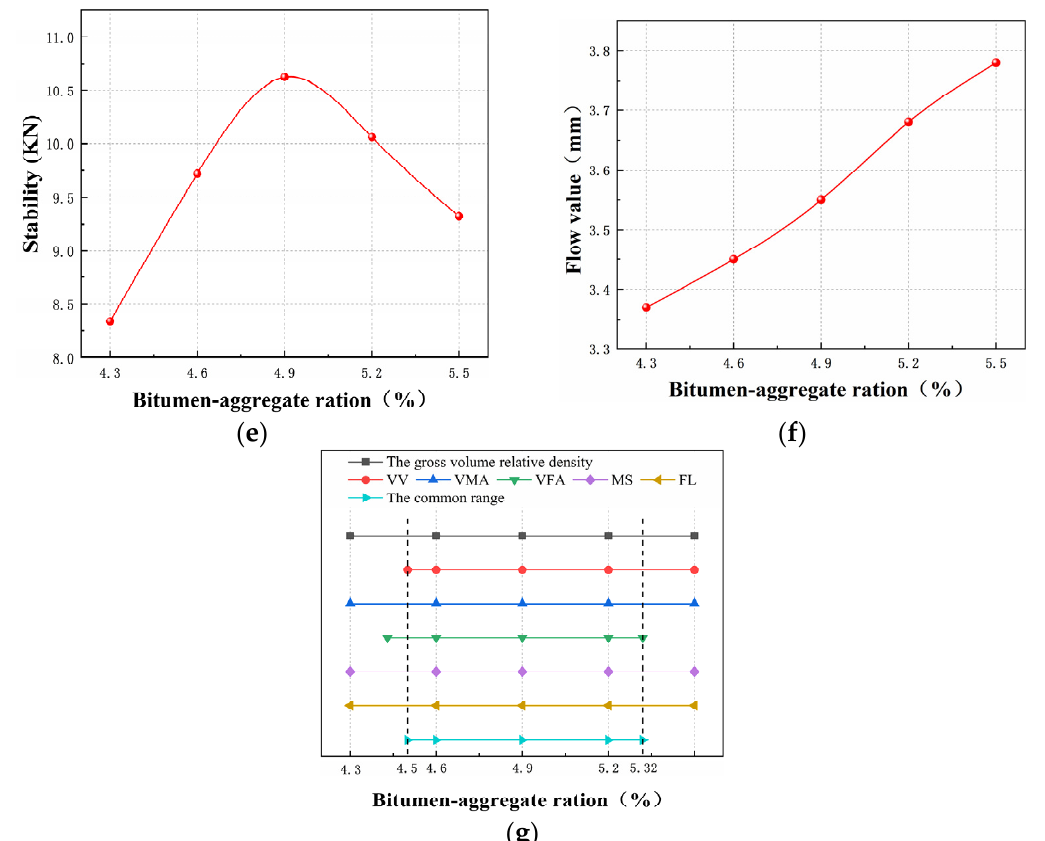
Figure 3. The physical mechanical index of 70# asphalt mixture. ( a ) The gross volume relative density; ( b ) Saturation; ( c ) Voids in mineral aggregate; ( d ) Saturation; ( e ) MS; ( f ) FL; ( g ) The common range.